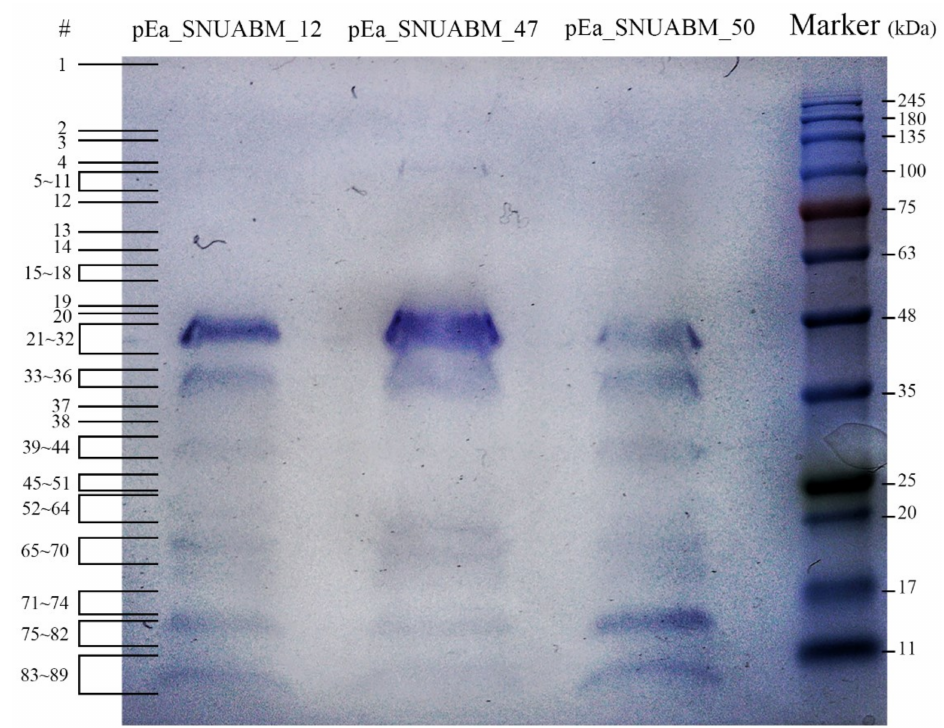
Figure 6. Protein analysis of phages pEa_SNUABM_12, pEa_SNUABM_47, and pEa_SNUABM_50. The number on the left side indicates the proteins identified by mass spectrometry and match with the number in the Table